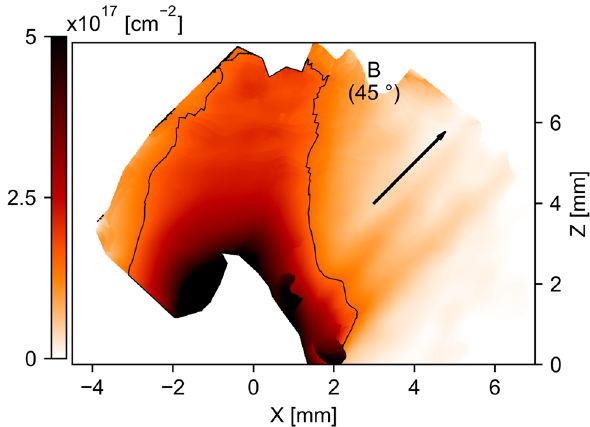
Fig. 3 Experimental plasma expansion for large misalignment and late time. The electron density, integrated along the probe line of sight, is shown at 45 degrees of misalignment and at 47 ns after the start of plasma expansion. The contour follows the 1.5 × 10 17 cm − 2 integrated density value. The black arrow indicates the initial magnetic fi eld direction.